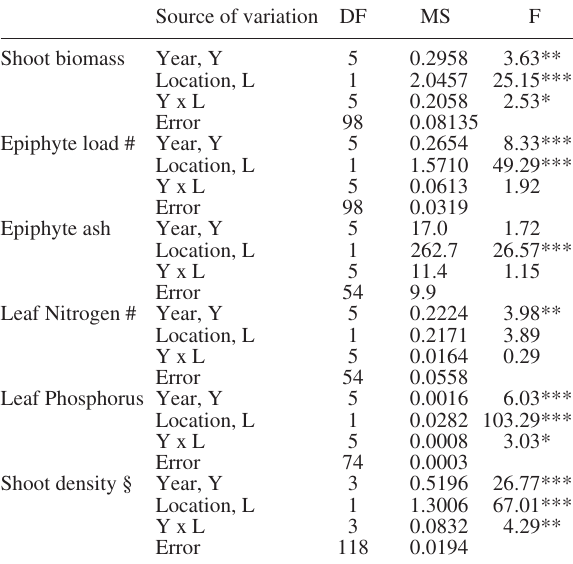
Table 1. – Results of analysis of variance (DF, degrees of freedom; MS, mean square; F, F-ratio) to determine whether there were dif- ferences in shoot biomass, epiphyte load, ash content of epiphytes, nitrogen and phosphorus content of the leaves and shoot density of Posidonia oceanica between years (2003 to 2008) and locations (Magaluf, Ses Salines) off Mallorca, western Mediterranean. Sig- nificant sources of variation are indicated by asterisks: *, P <0.05; **, P <0.01; ***. P <0.001. § Data were log-transformed. # Data transformation did not homogenize variances.